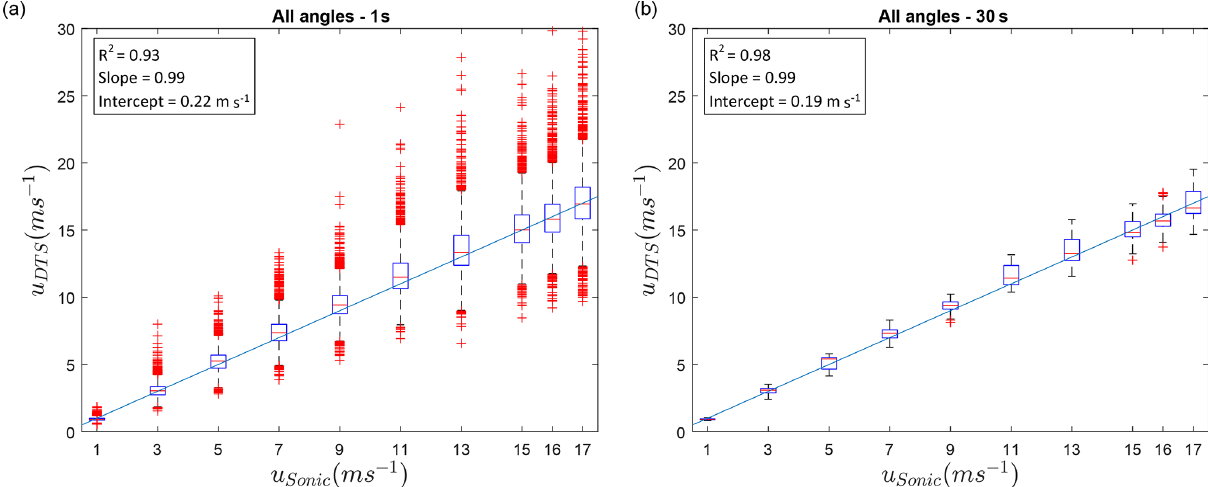
Figure B2. Comparison of AHFO and sonic anemometer wind speed, combining all angles of attack at a 1s (a) and 30s (b) resolution; n space = 10, n time = 1 and 30. The line represents the 1 : 1 line.